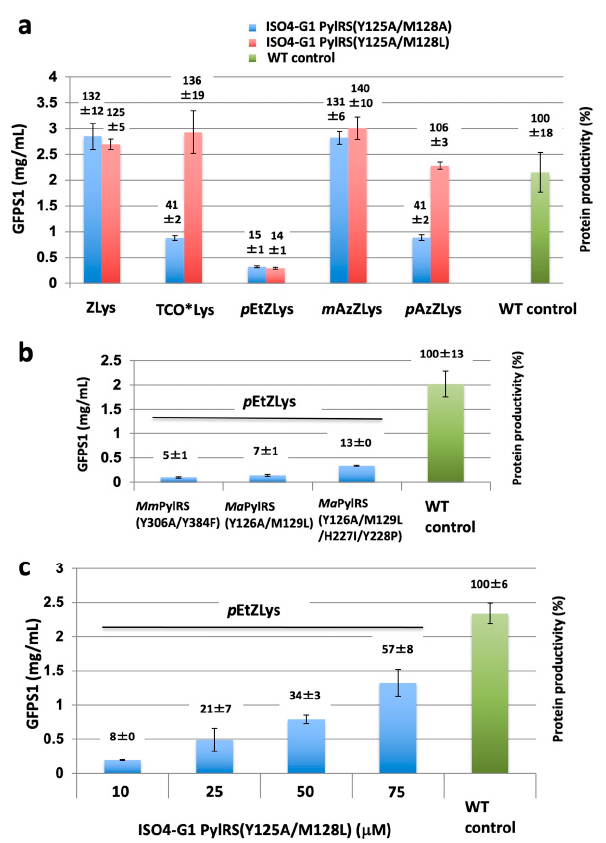
Figure 6. Cell-free protein synthesis for site-specific incorporation of non-canonical amino acids into the N11-GFPS1 protein by using ISO4-G1 PylRS with the first-layer mutations. The N11-GFPS1 pro- teins containing non-canonical amino acids were synthesized with the S30 extract from the E. coli RF1 deletion strain B-60 Δ A::Z/pMINOR cells. Non-canonical amino acids were site-specifically in- corporated into the N11-GFPS1 protein at position 17 in response to the UAG codon, by using the ISO4-G1 PylRS (Y125A/M128L)·tRNA Pyl and ISO4-G1 PylRS (Y125A/M128A)·tRNA Pyl pairs. Protein productivities with non-canonical amino acids were compared with that of the cell-free synthesis of wild-type N11-GFPS1 protein containing Ala at position 17 (WT control) and are shown above the bars. ( a ) The yields of the N11-GFPS1 proteins containing ZLys, m AzZLys, p AzZLys, p EtZLys, and TCO*Lys were estimated by fluorescence. The values represent the means of three independent ex- periments with standard deviations. ( b ) Cell-free synthesis of the N11-GFPS1 protein containing p EtZLys by using 10 μ M of the M. mazei PylRS (Y306A/Y384F), M. alvus PylRS (Y126A/M129L), and M. alvus PylRS (Y126A/M129L/H227I/Y228P) proteins. The values represent the means of three in- dependent experiments with standard deviations. ( c ) Cell-free protein synthesis of the GFPS1 pro- tein containing p EtZLys, using increased concentrations (from 10 to 75 μ M) of the ISO4-G1 PylRS (Y125A/M128L) protein. The values represent the means of three independent experiments with standard deviations.